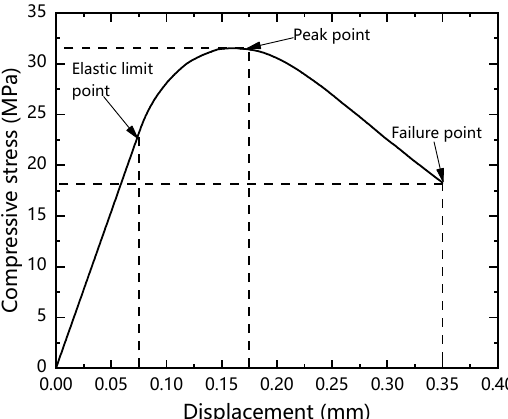
Figure 5. Numerically obtained compressive stress-displacement curve of a typical test cube under compressive loading.